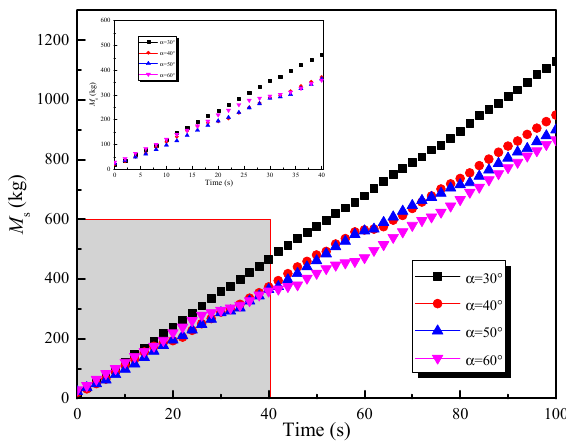
Figure 20. The variation in mass discharge with operating time for different half hopper angles.